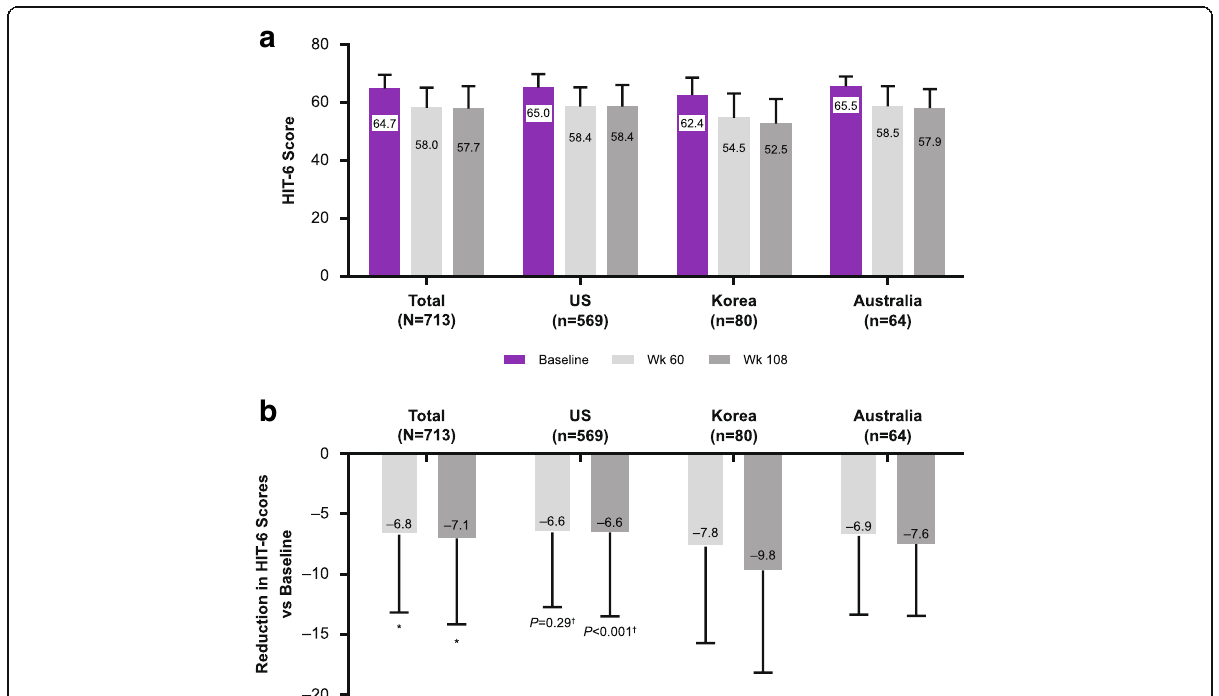
Fig. 5 Long-term effect of onabotulinumtoxinA by country. a ) HIT-6 total score and b ) change in HIT-6 total score vs baseline, depicting the outcomes after 5 (wk 60) and 9 (wk 180) treatments. HIT-6=6-item Headache Impact Test. *Indicates P <0.001 vs baseline; paired t -test used to compare visit to baseline. † Indicates P =0.0008 for comparison between subgroups; 1-way analysis of